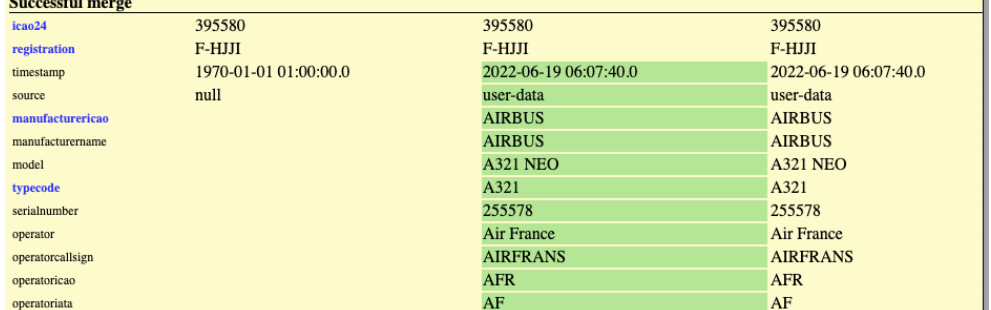
Figure 2. Astroturfing event. A non-existing Air France aircraft with registration F-HJJI is added to the transponder ID 395580 , then registered to LVMH Services GIE. Previously, there were no data in the